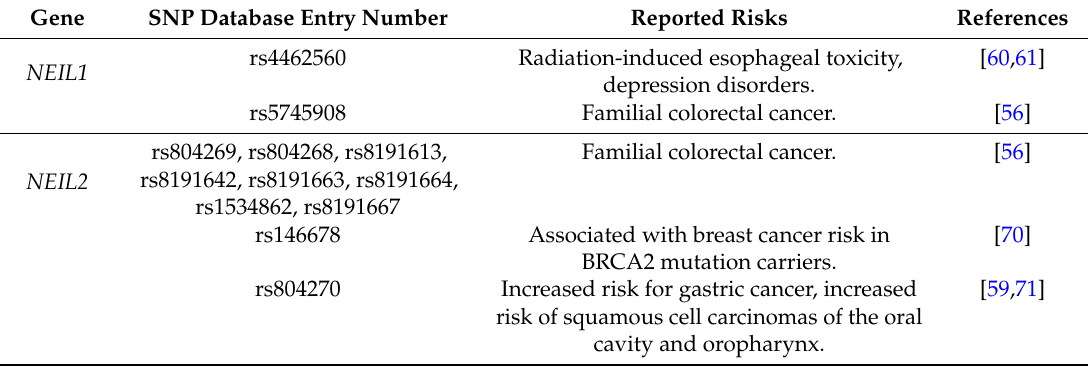
Table 2. Association of NEIL1 and NEIL2 with single nucleotide polymorphisms (SNPs) and reported disease-associated